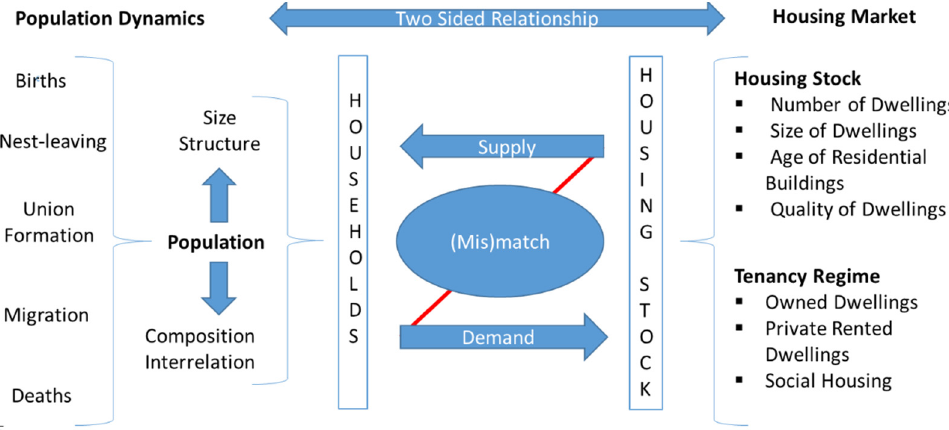
Figure 1. Two-sided relationship between population dynamics and housing market. Source: Own elaboration.